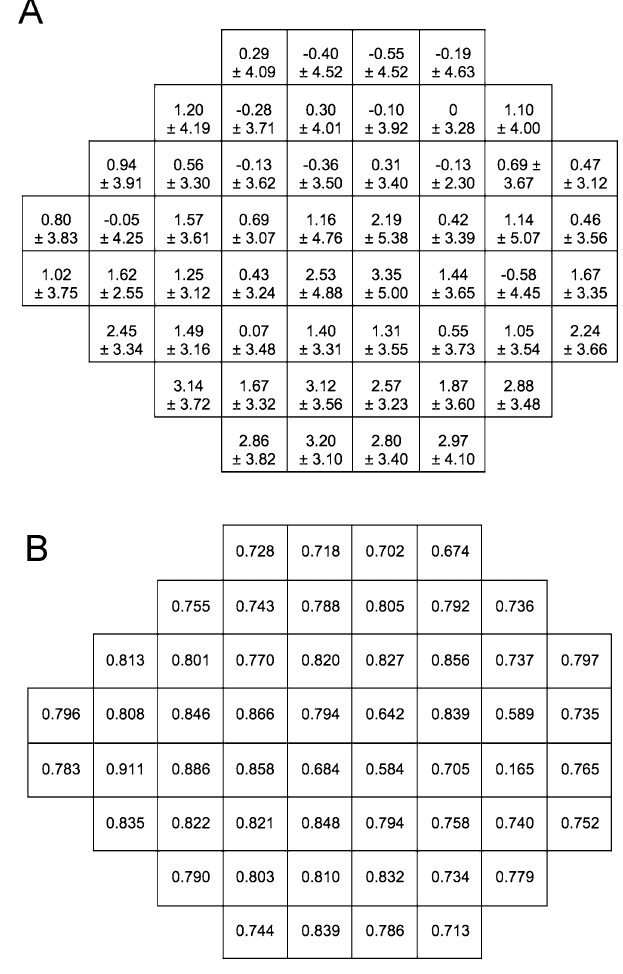
Figure 4. Mean (± standard deviation (SD)) differences (in decibels) between threshold sensitivities from standard automated perimetry (SAP) and saccadic vector optokinetic perimetry (SVOP) at each location of the visual field ( A ) and correlation between SVOP and SAP sensitivity for each test location ( B ). Negative values indicate threshold sensitivity measured by SVOP was lower than that measured by